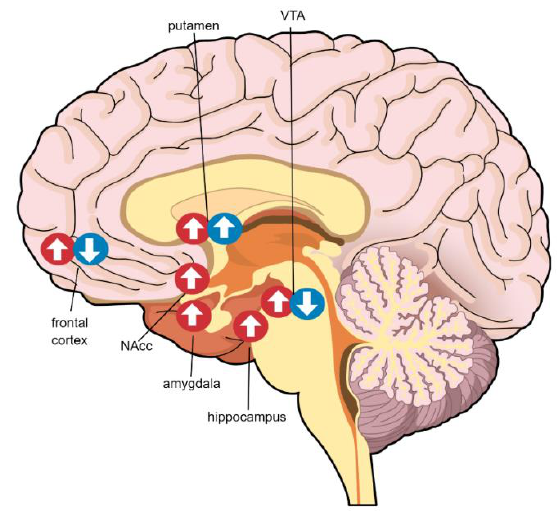
Figure 2. Resting state connectivity differences in obesity by sex/gender. Red circles indicate changes among females and blue circles indicate changes among males. Arrows indicate the direction of the correlation between centrality and obesity metrics (i.e., BMI, total body fat, serum leptin, Yale Food Addiction Scale (YFAS) score). VTA: ventral tegmental area.